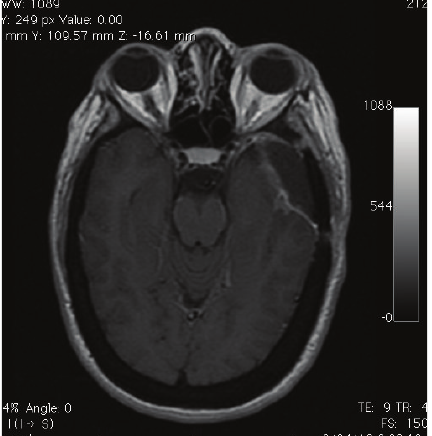
Figure 11: Postoperative (24 hr) follow-up T1-WI axial MRI demon- strates complete resection of tumor from the middle region.